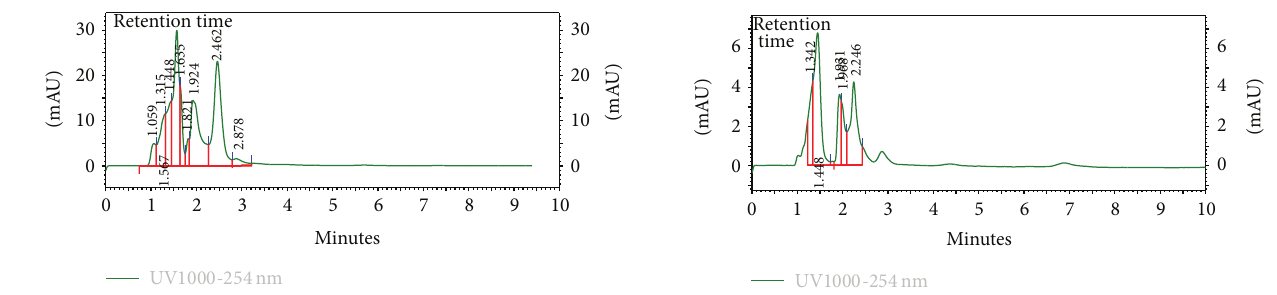
Figure 3: HPLC chromatogram (finger-printing) of methanol leaf extract (SHL) of S. hispidus at 𝜆 254 nm.